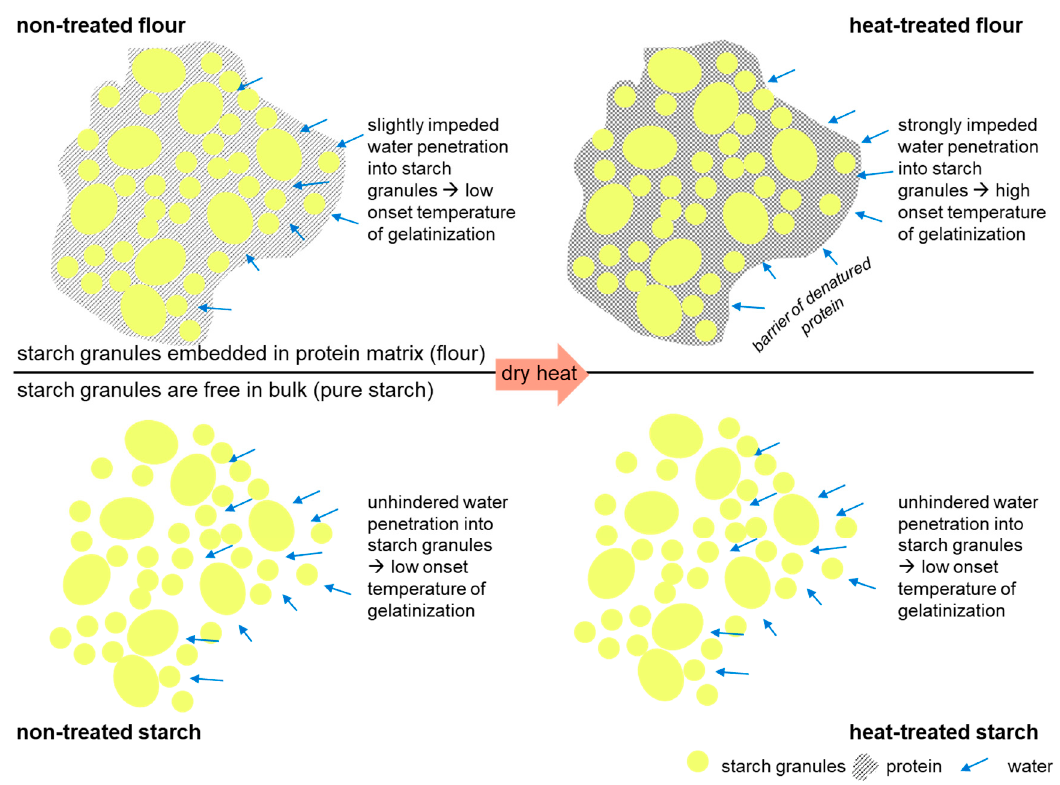
Figure 5. Schematic illustration of the formation of a protein barrier in heat treated wheat matrices and resulting water shielding effect.